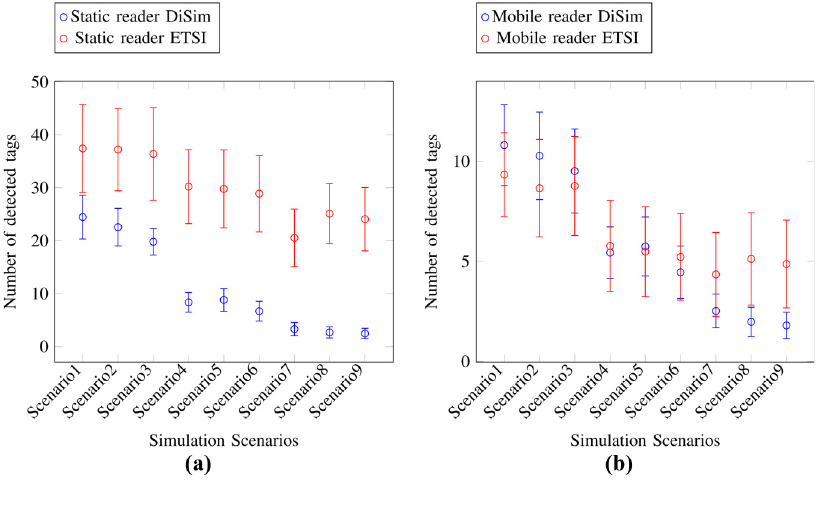
Figure A1. Maximum and average number of successful tag- reading operations for static and mobile readers, for both mid- and high-coverage areas